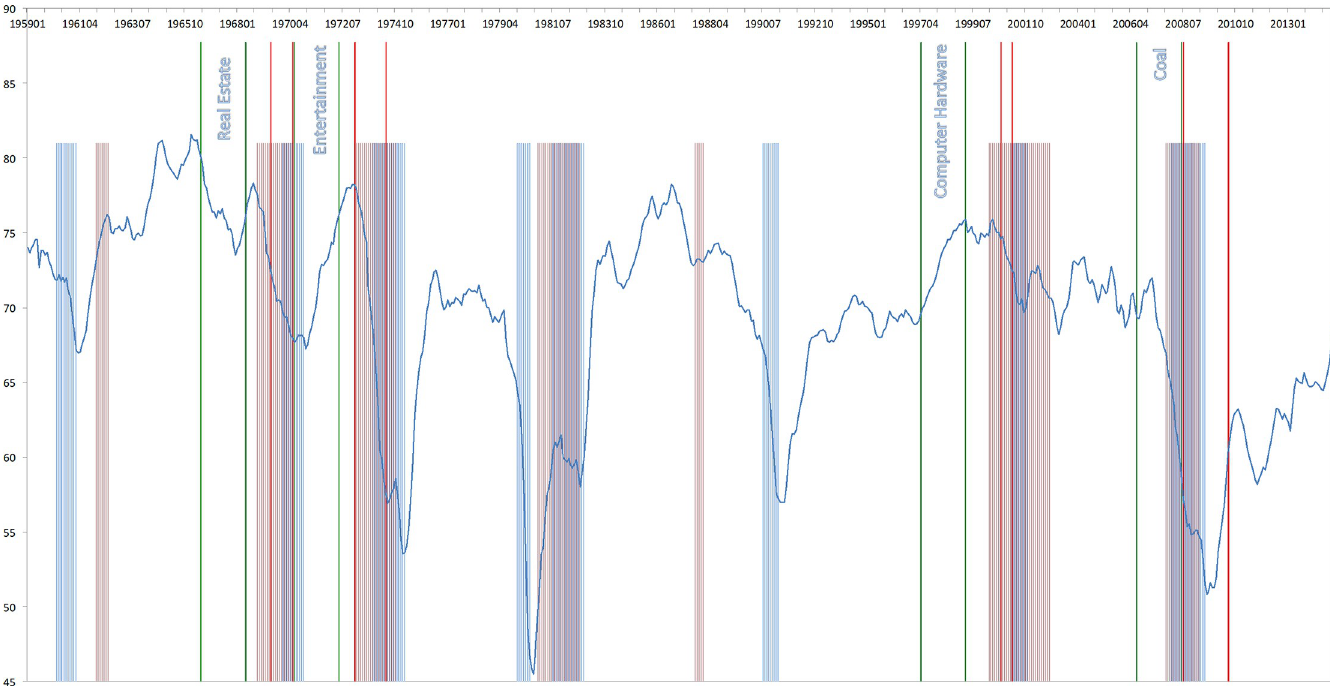
episode, the two green bars indicate the start and the end of the run-up period. The subsequent two red bars indicate the start and the end of the crash period. For each run-up/crash episode, the industry is mentioned.